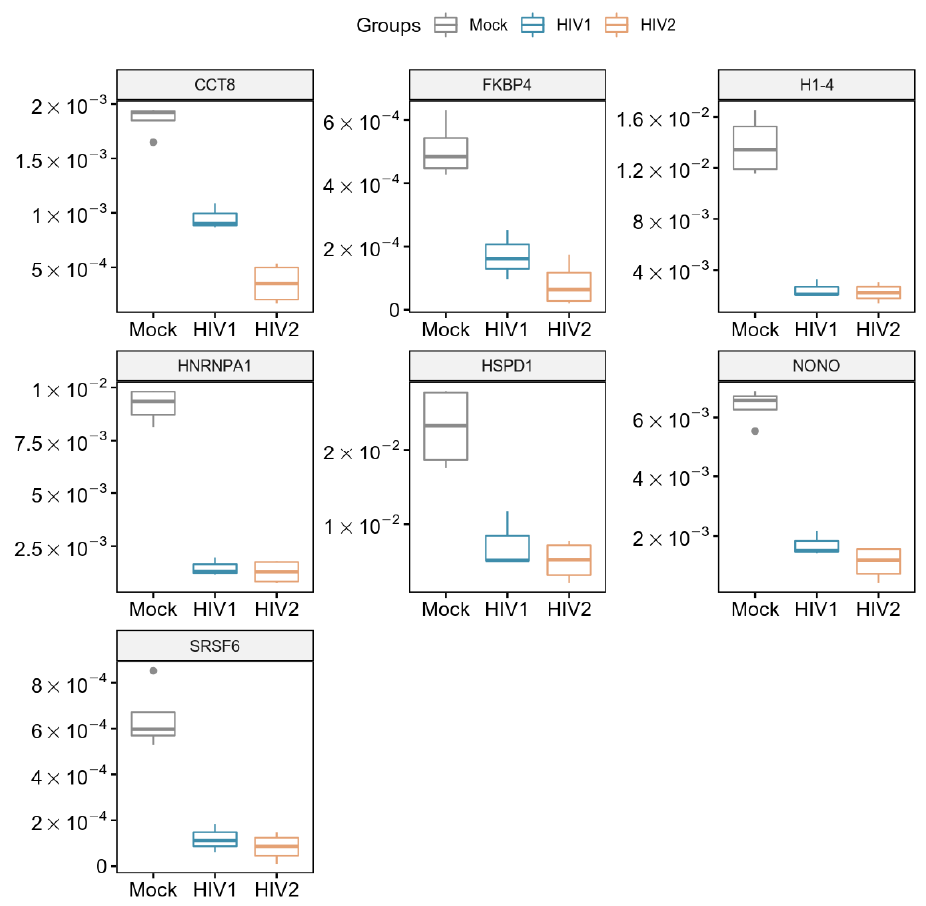
Figure 5. Downregulated proteins at 2 h time-point. Boxplot of the downregulated proteins showing statistically significant changes as a result of HIV-1 and 2 transduction. p -value < 0.05. CCT8 and FKBP4 were only significant in HIV-2 transduced cells.